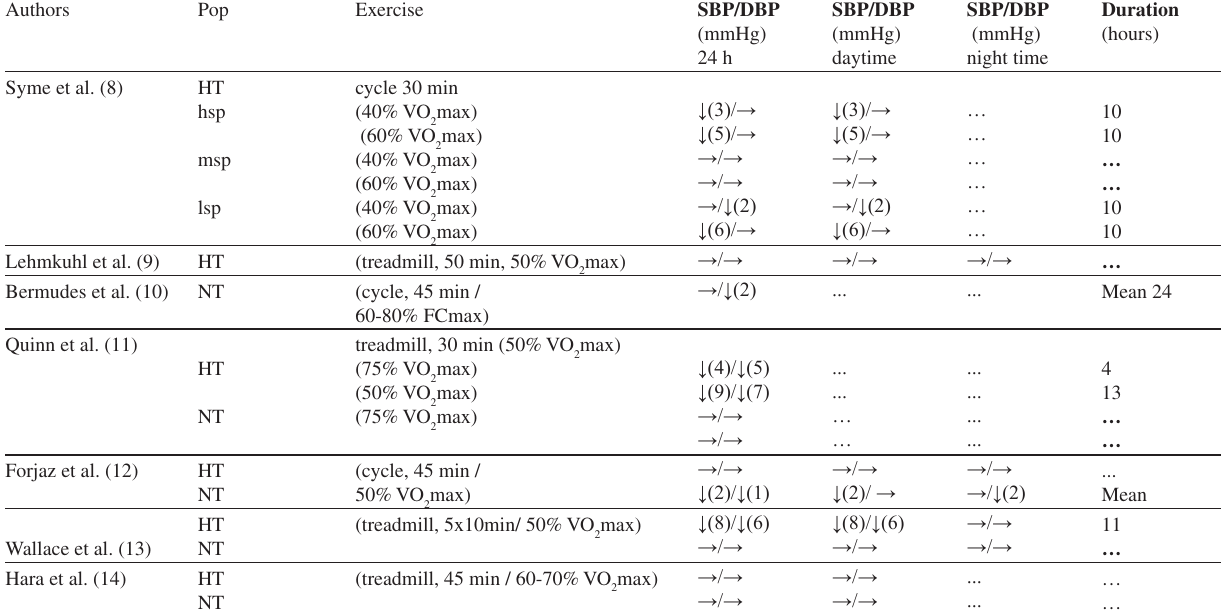
Table 1 - Effects of aerobic exercise on post-exercise ambulatory blood pressure